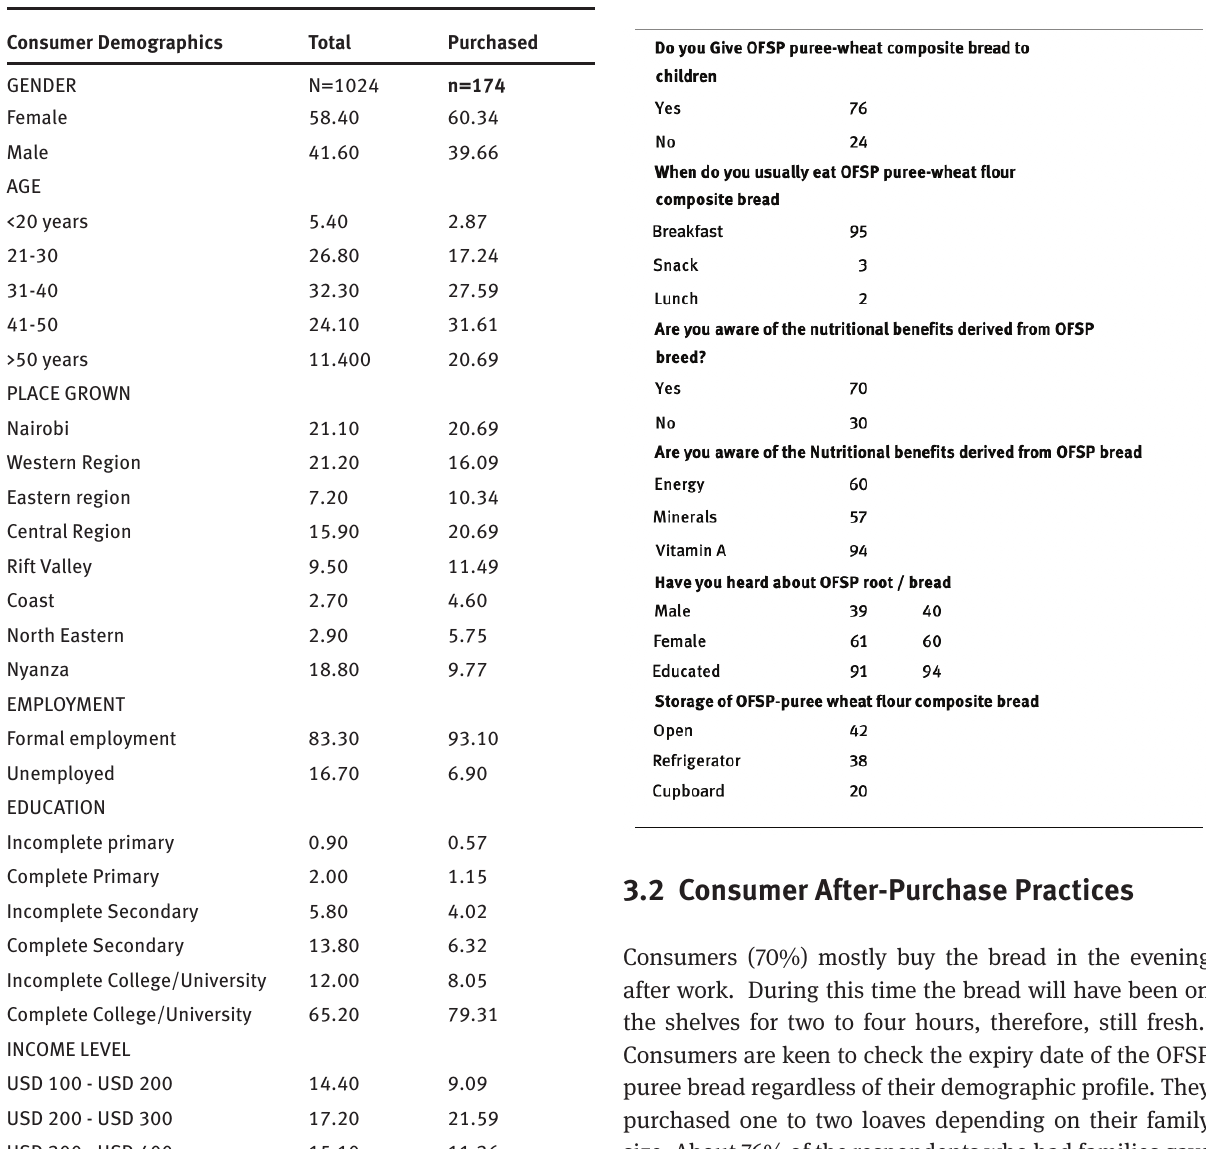
Table 1: Consumer demographics as percentage Table 2: Consumers’ knowledge and